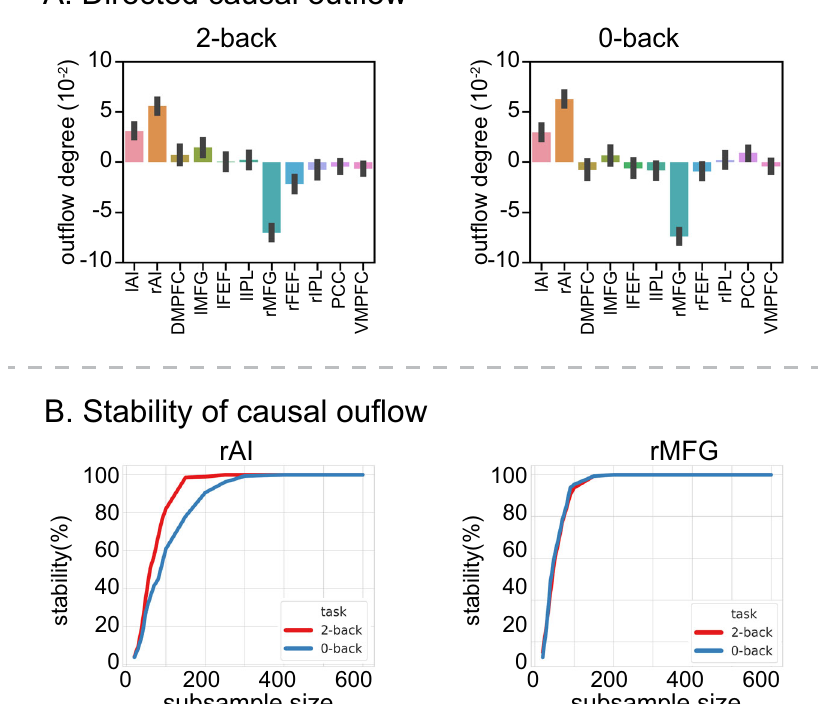
Fig. 3 Working-memory load-speci fi c dynamic causal out fl ow. A AI showed the highest directed causal out fl ow between SN, FPN, and DMN nodes in both the 2-back and 0-back working-memory task conditions ( p < 0.05, FDR-corrected, two-sided t -test). n = 737 participants. Data are presented as mean ± SEM. In contrast, the rMFG showed the highest directed causal in fl ow among all nodes in both task conditions ( p < 0.05, FDR-corrected, two-sided t -test). n = 737 participants. Data are presented as mean ± SEM. B Stability analyses revealed highly stable directed causal out fl ow from the rAI and directed causal in fl ow into the rMFG in both the 2-back and 0-back working-memory task conditions. X -axis shows sample size, ranging from 20 to 600. Y - axis shows stability, computed as the probability that the rAI shows the highest positive directed causal out fl ow among SN, FPN, and DMN nodes, and the probability that the rMFG shows the highest causal in fl ow in random subsamples drawn from N = 737 participants. lAI left anterior insula, rAI right anterior insula, DMPFC dorsomedial prefrontal cortex, lMFG left middle frontal gyrus, rMFG right middle frontal gyrus, lFEF left frontal eye fi eld, rFEF right frontal eye fi eld, lIPL left intraparietal lobule, rIPL right intraparietal lobule, PCC posterior cingulate cortex, VMPFC ventromedial prefrontal cortex. Source data are provided as a Source data fi le.